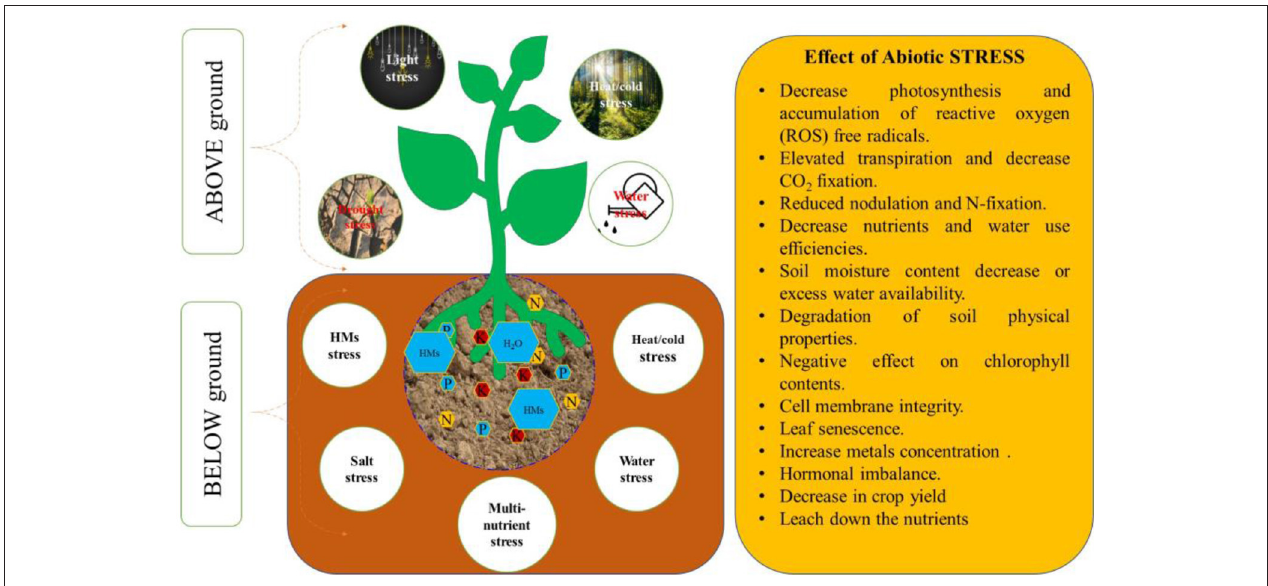
FIGURE 1 | Abiotics tree conditions and their effect on the growth and development of